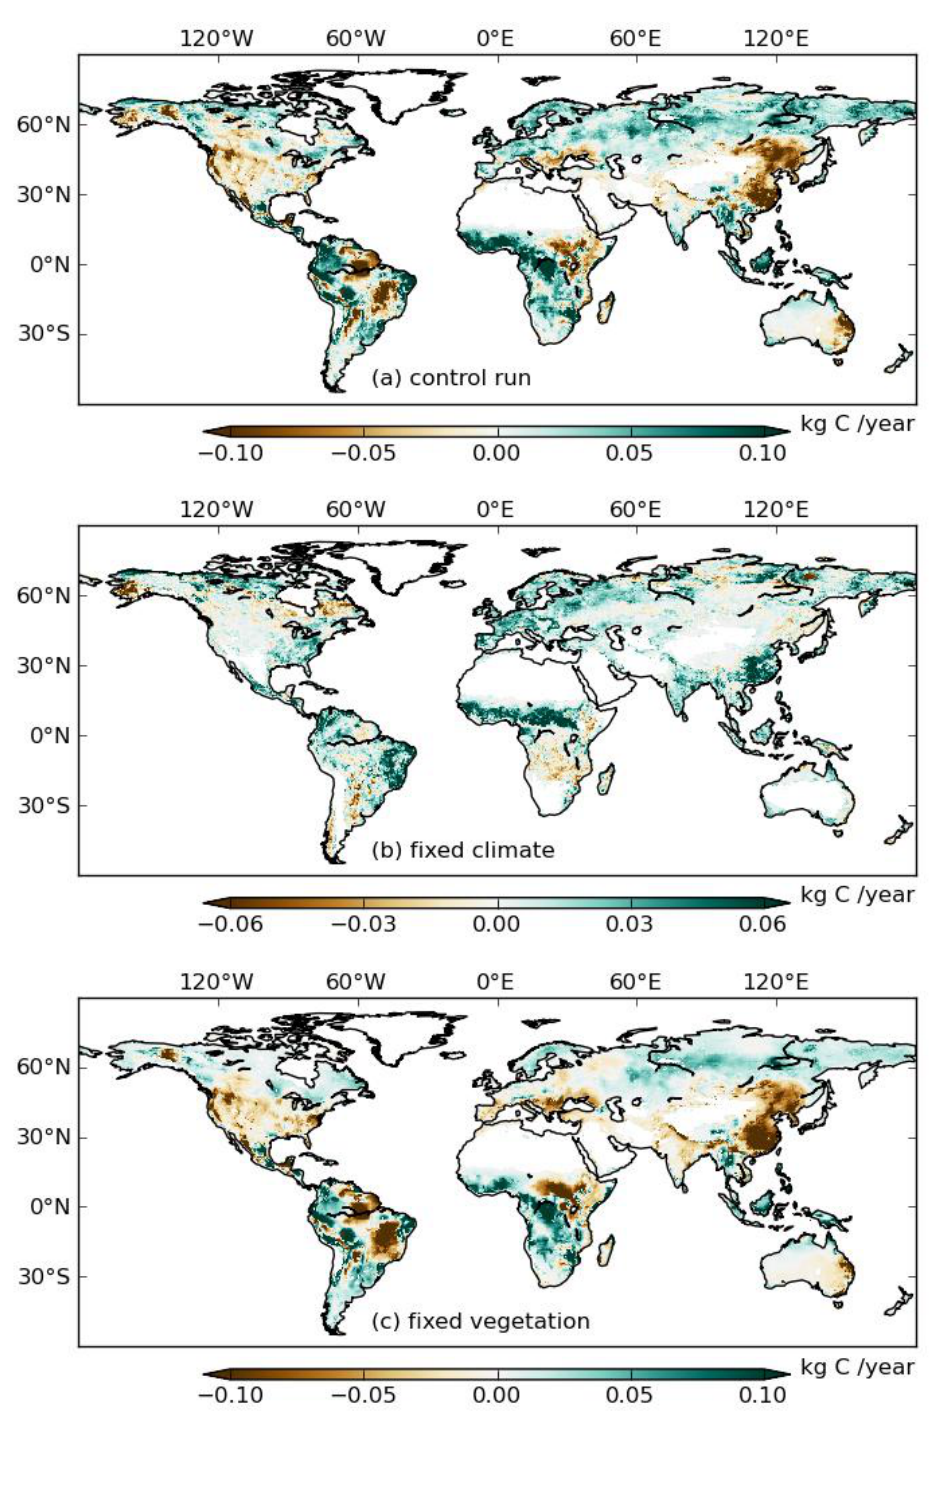
Figure 3. Difference of mean annual Gross Primary Production (GPP) between 2000–2009 and 1982–1999. Panel ( a–c ) are simulated with control run ( S_control ), fixed climate run ( S_veg ), and fixed vegetation run ( S_clim ),